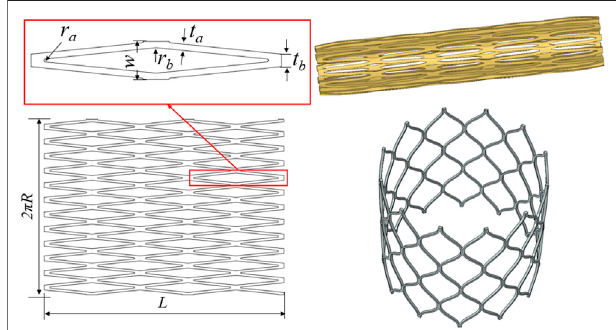
FIGURE 1 | Diagram of the geometric structure of the aortic valve stent and three-dimensional model.